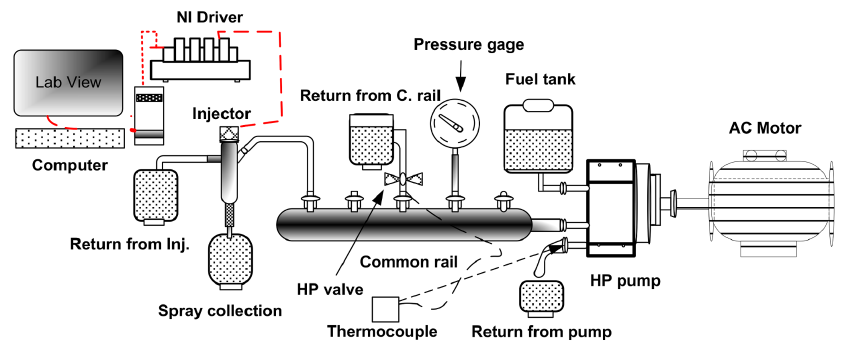
Figure 2. Schematic of the experimental